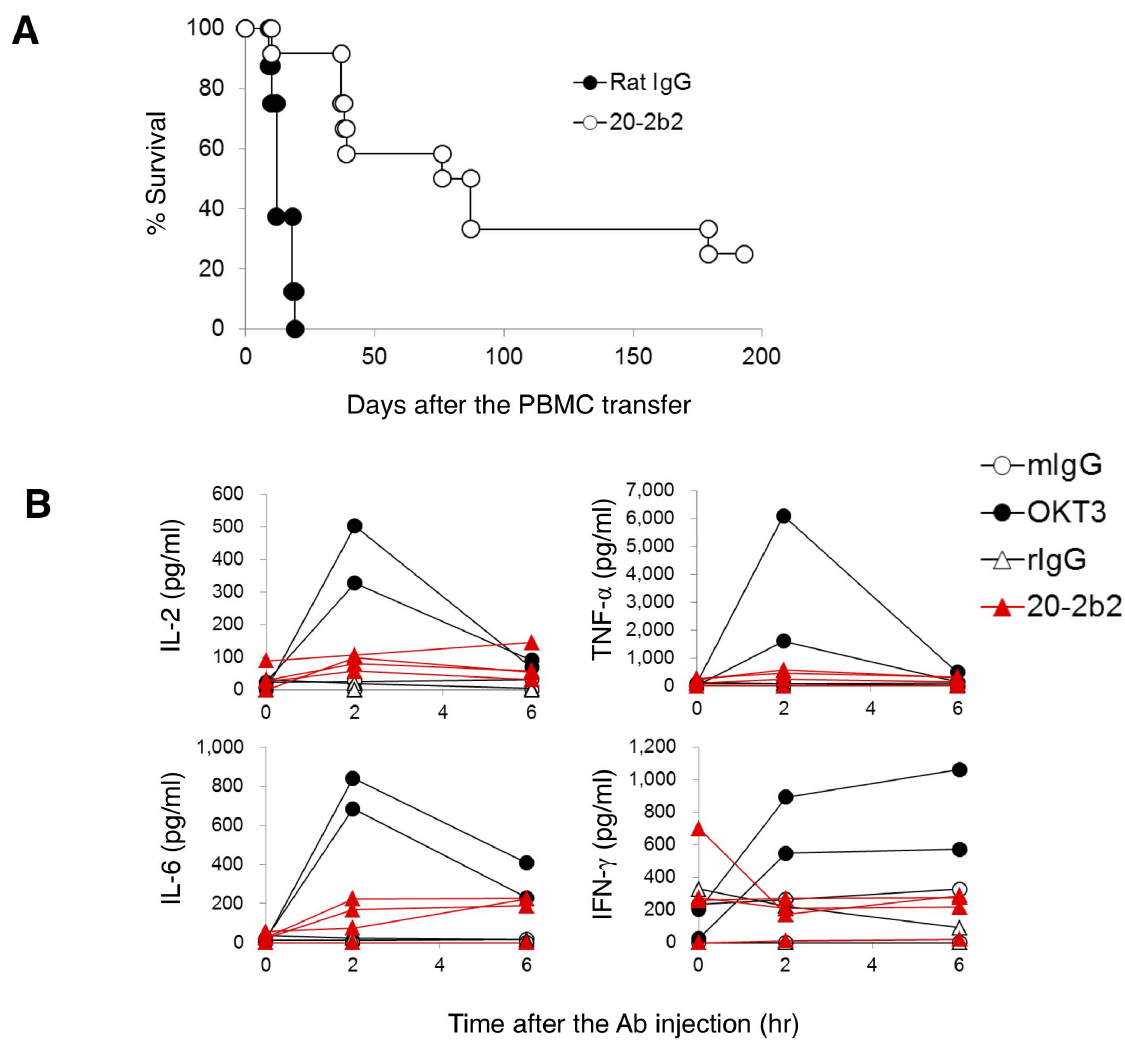
Figure 6. Immunosuppressive activity of 20-2b2 invivo . (A) Irradiated (2 Gy) NOG mice were intravenously injected with whole PBMCs (2 6 10 6 / mouse) from a healthy donor on day 0. Mice were intravenously injected with the control Ab (closed symbols, n=8) or 20-2b2 (open symbols, n=12) on days 2, 9, and 16 (20 m g/mouse/injection). The survival of mice was monitored. Data from two independent experiments were pooled. p , 0.001 in rat IgG versus 20-2b2, by the F-test. (B) Hu-NOG mice were intravenously injected with one of the following Abs (20 m g/mouse); control mouse IgG 2a (mIgG), rat IgG (rIgG), OKT3, or 20-2b2. Serum samples were obtained 0, 2, and 6 hours after the injection. Cytokine levels were measured. Data from the same Hu-NOG mouse are linked with a line. Data from two experiments are shown. Standard deviations were less than 10% of the